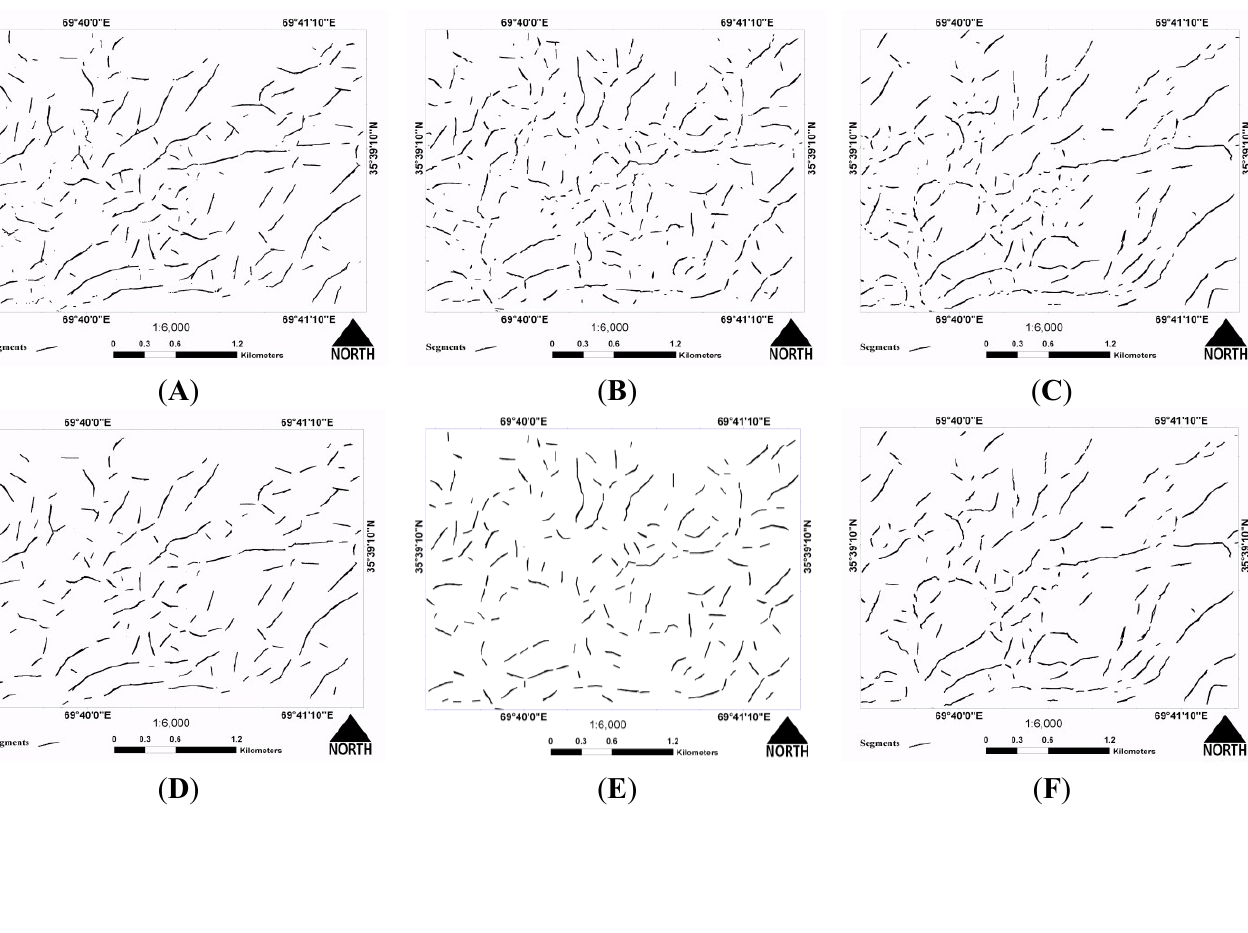
Figure 12. ( A – C ): Extracted line segments using HT for binary edge data sources from Sobel, LOG method and Canny methods, respectively; ( D – F ): Intermediate discontinuity map after applying Tavares-Padilha algorithm; ( G – I ): Final lineament maps from polynomial interpolation using B-spline method for Sobel, LOG and Canny edge data sources, respectively. ( J ): Extracted discontinuities using